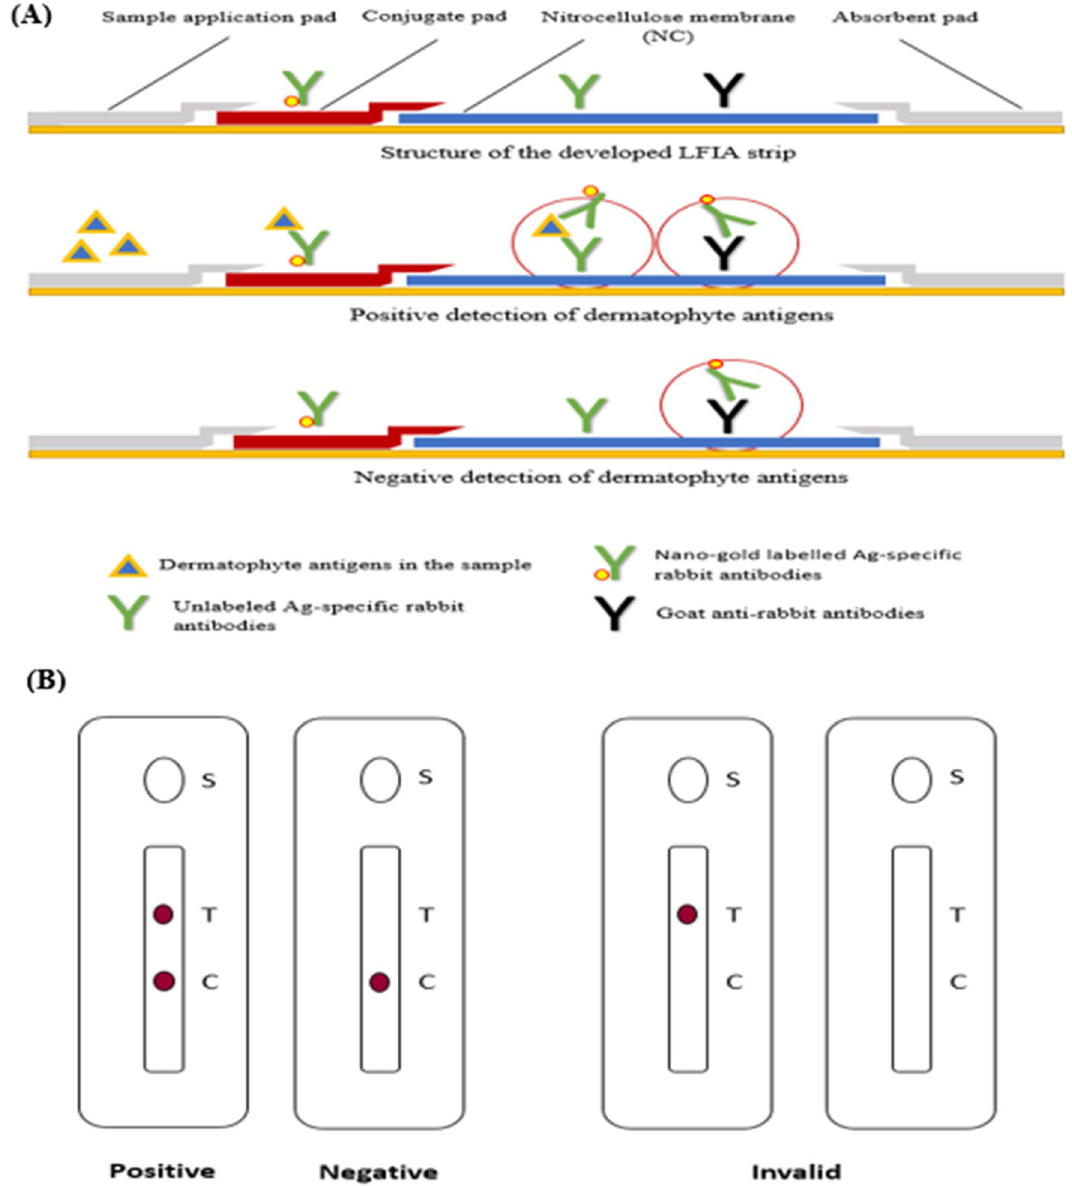
Figure 1. ( A ) Diagrammatic illustration of the working principle of the newly developed kit. ( B ) Illustration of the valid (positive/negative) and the invalid visible outcome results.